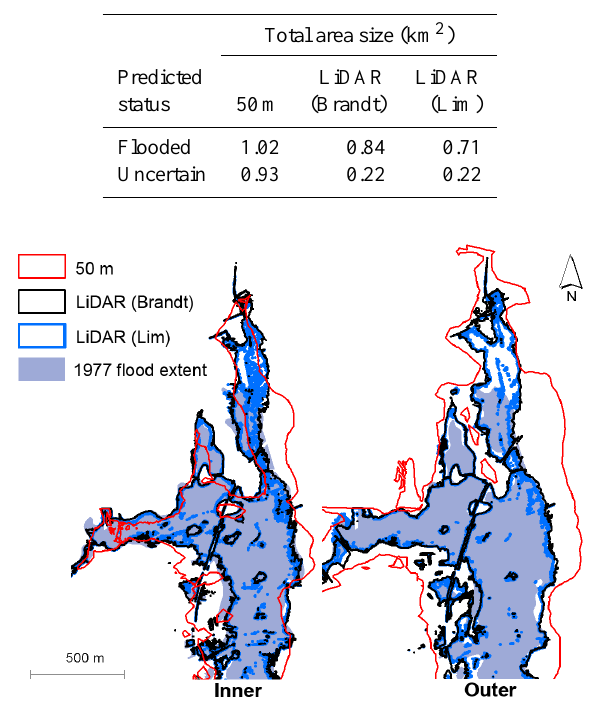
Table 1. Total sizes of areas predicted to be uncertain and flooded using the disparity-distance equation.